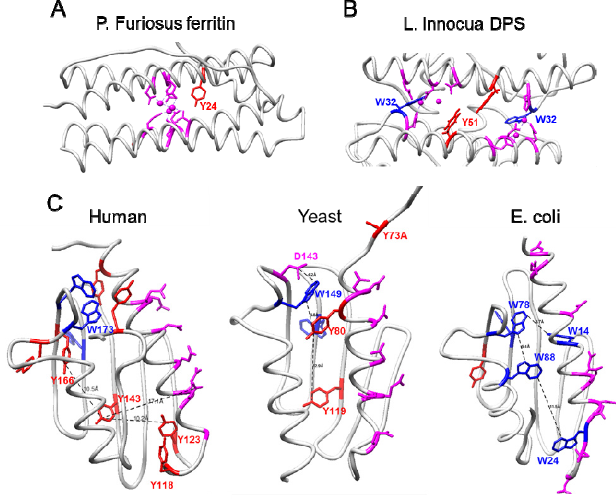
Figure 6 . ( A ) Ribbon representation of one subunit of ferritin from Pyrococcus furiosus (PDB ID: 2JD7). A highly conserved tyrosine (Y24) is present in the vicinity (4–5 Å) of the ferroxidase center (shown in magenta) which is rich in acidic residues. ( B ) In Listeria innocua DPS (PDB ID: 6HX2), the ferroxidase center is formed at the interface of two subunits. A highly conserved tryptophan (W32) is present near the ferroxidase center (shown in magenta), while a nearby tyrosine (Y51) is placed 7.5 Å away from the tryptophan residue. ( C ) Ribbon representations of human and S. cerevisiae frataxins, and CyaY from E. coli. Tryptophans are shown in blue, tyrosines in red, while putative iron-binding acidic residues are shown in magenta. Those residues mentioned in the main text are indicated. In 3OER S. cerevisiae structure, Y73 is replaced by an Alanine. A visual inspection of the distribution of these residues in human frataxin indicates that most of them are separated by less than 10 Å, a distance that would allow electron transfer between them (Figure 6C). Tyrosine 143 (from cluster 3) is placed between Y123 and Y166 ( ∼ 10 Å away from each one). Several tyrosines and tryptophans are placed in the vicinity of Y123 or Y166, close enough to mediate electron transfer reactions between these residues and the putative iron-binding sites. In this regard, at least three putative iron-binding sites have been reported for frataxins: the acidic ridge (present in all frataxins and bacterial CyaYs), a high affinity site involving His86 (located in the disor- dered N-terminal tail), and a cavity between three frataxin subunits that was observed in the crystal structure of S. cerevisiae frataxin. This last iron-binding site would be formed by three aspartic residues (scD143) from three different frataxin polypeptide chains. This residue is conserved in human frataxin (D167), although its 3D disposition in the protein structure is slightly different. Interestingly, scD143 is ∼ 4 Å away from scW149, which has been identified by ConSurf analyses and included in cluster 1 (W173 in huFXN). ScY119 (Y143 in huFXN) is ∼ 17 Å from scW149, but an additional tyrosine placed in between (scY80) could facilitate electron transfer. Regarding human frataxin, several redox active aromatic residues are placed close to both D167 or the acidic ridge. It could be hypothe- sized that these residues would play a role in frataxin similar to the one played by the